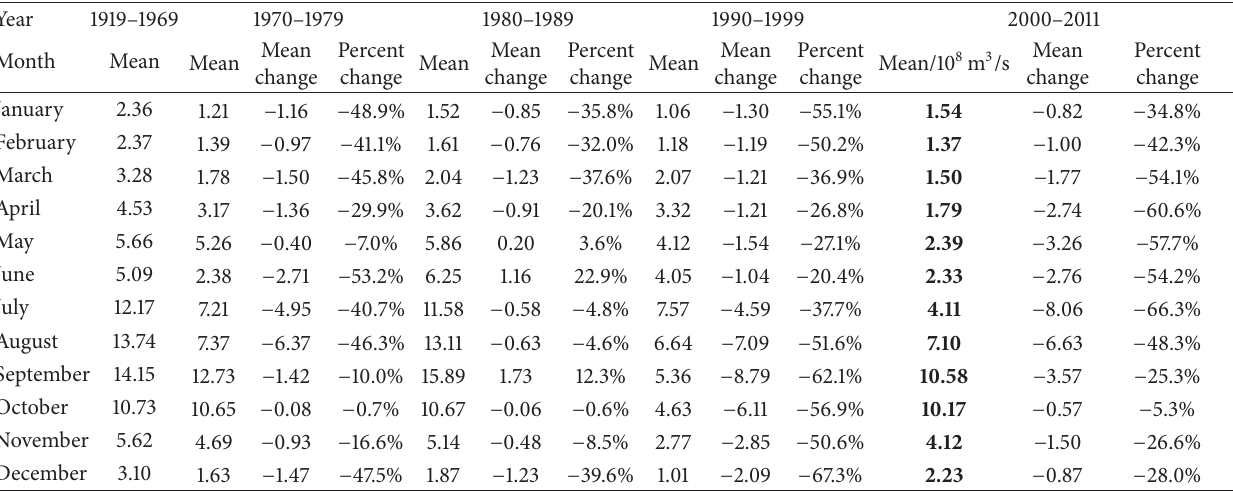
Table 2: Monthly runoff volumes during the five subperiods (10 8 m 3 ) and changes relative to baseline (1919–1969)